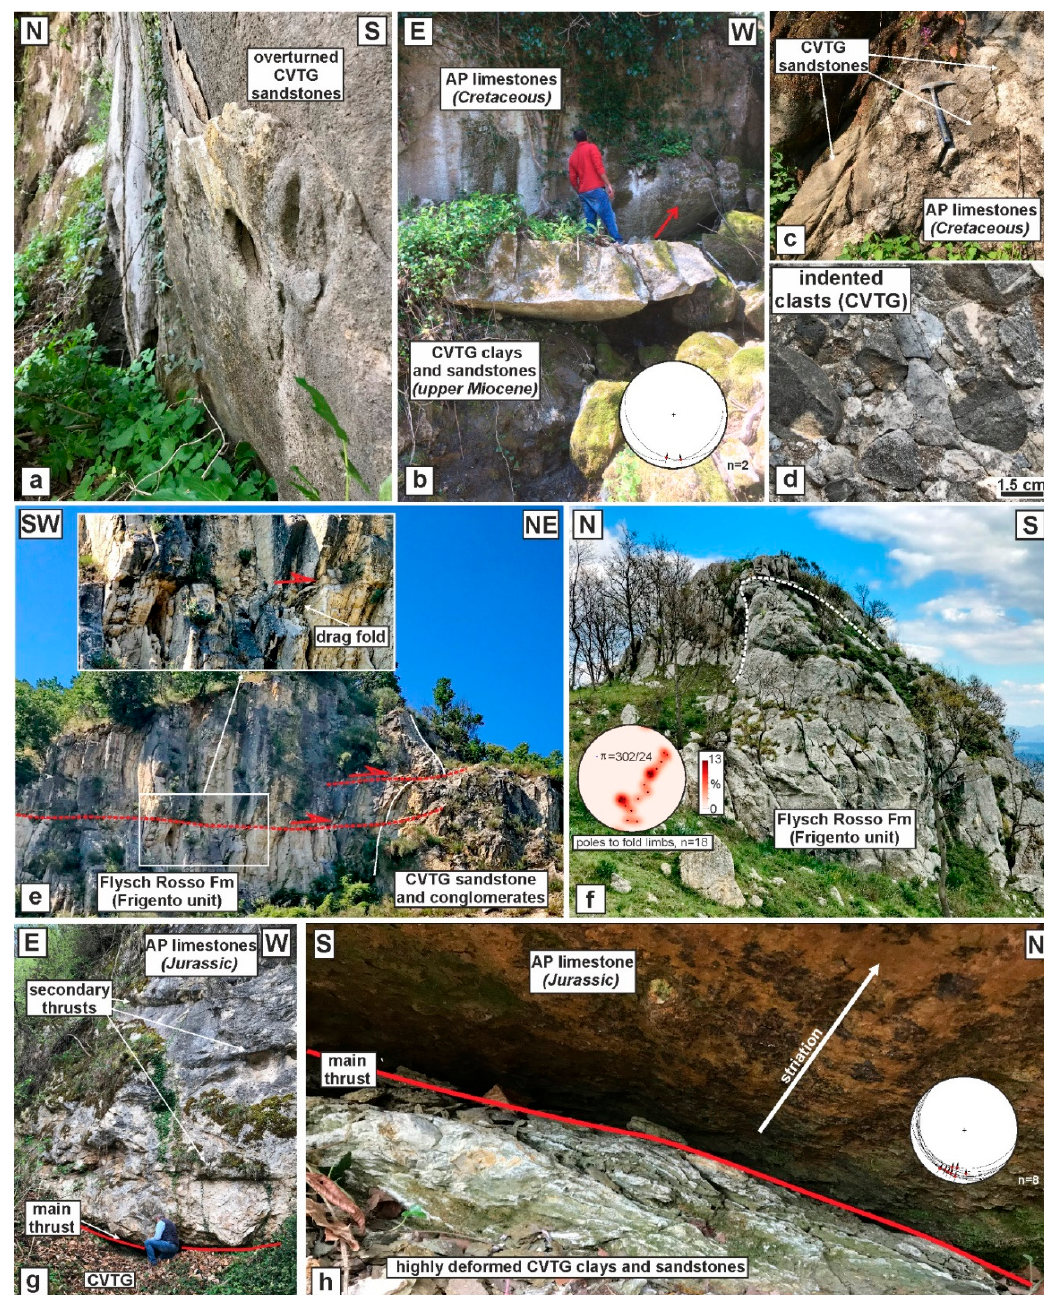
Figure 8. Pietrastornina: ( a ) overturned CVTG beds; ( b ) main thrust fault of Apennine Plattform (AP) Cretaceous limestones onto shales and sandstones of CVTG; ( c ) CVTG sandstone covering AP Cretaceous limestones; ( d ) indented calcareous clasts in CVTG; ( e ) vertical beds of Flysch Rosso Fm crosscut by a sub-horizontal thrust verging to NE with associated drag folds in the footwall. Mt Taburno: ( f ) overturned fold in Flysch Rosso Fm verging to the north; ( g , h ) the main thrust between AP Jurassic carbonates onto highly deformed clays of CVTG.